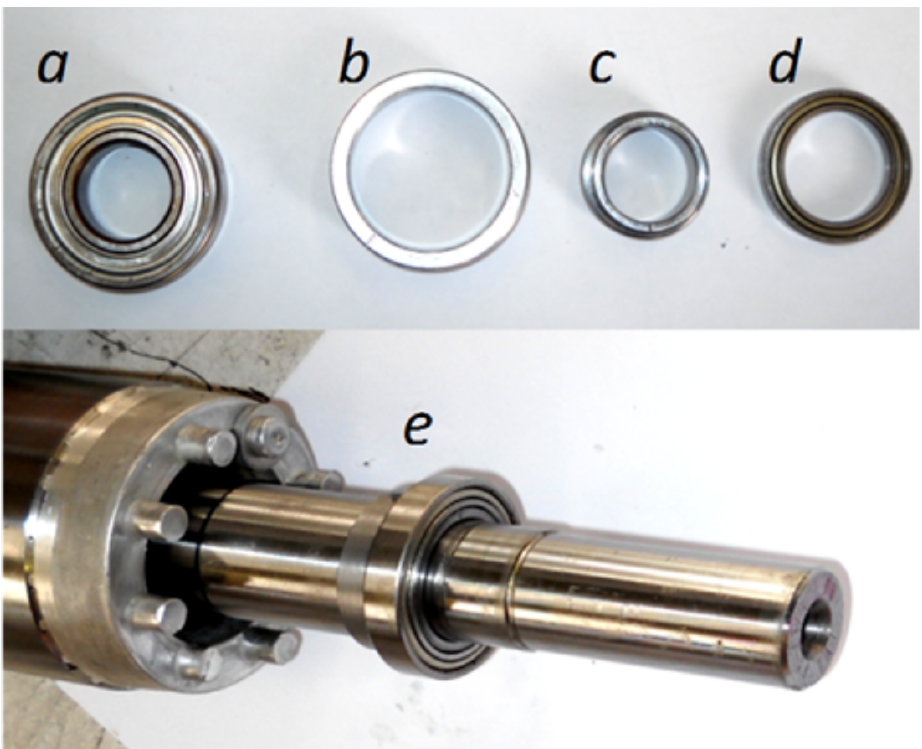
Figure 13. Rotor of the eccentric motor unit. Top, from left to right: ( a ) original bearing, ( b ) external and ( c ) internal eccentric rings, and ( d ) new bearing. Bottom: ( e ) mounted unit on the